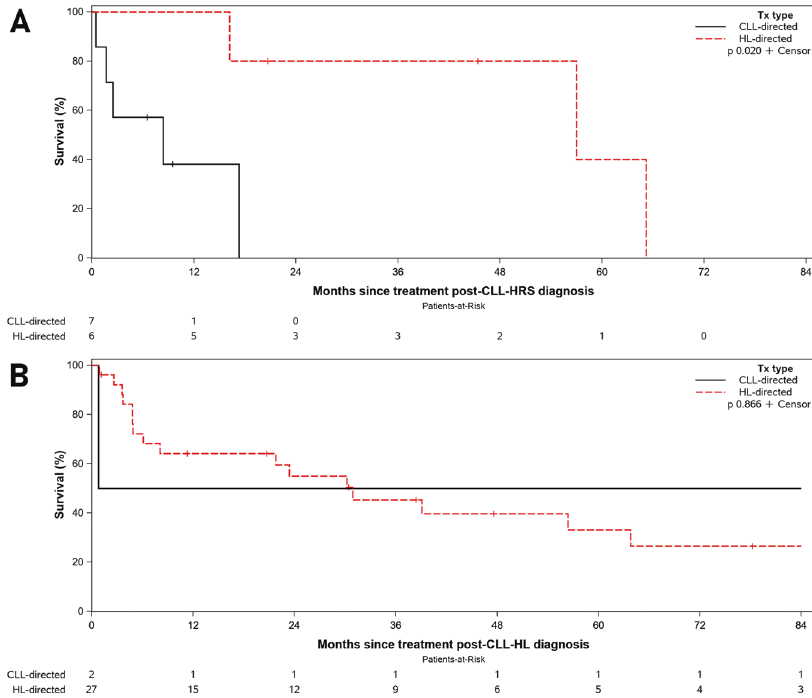
Fig. 4 Overall survival based on treatment administered. A Overall survival among patients with CLL with Reed – Sternberg-like cells (CLL- HRS) according to the type of treatment administered — CLL-directed and Hodgkin lymphoma (HL)-directed therapy. B Overall survival among patients with CLL with Hodgkin lymphoma according to the type of treatment administered — CLL-directed and Hodgkin lymphoma (HL)- directed